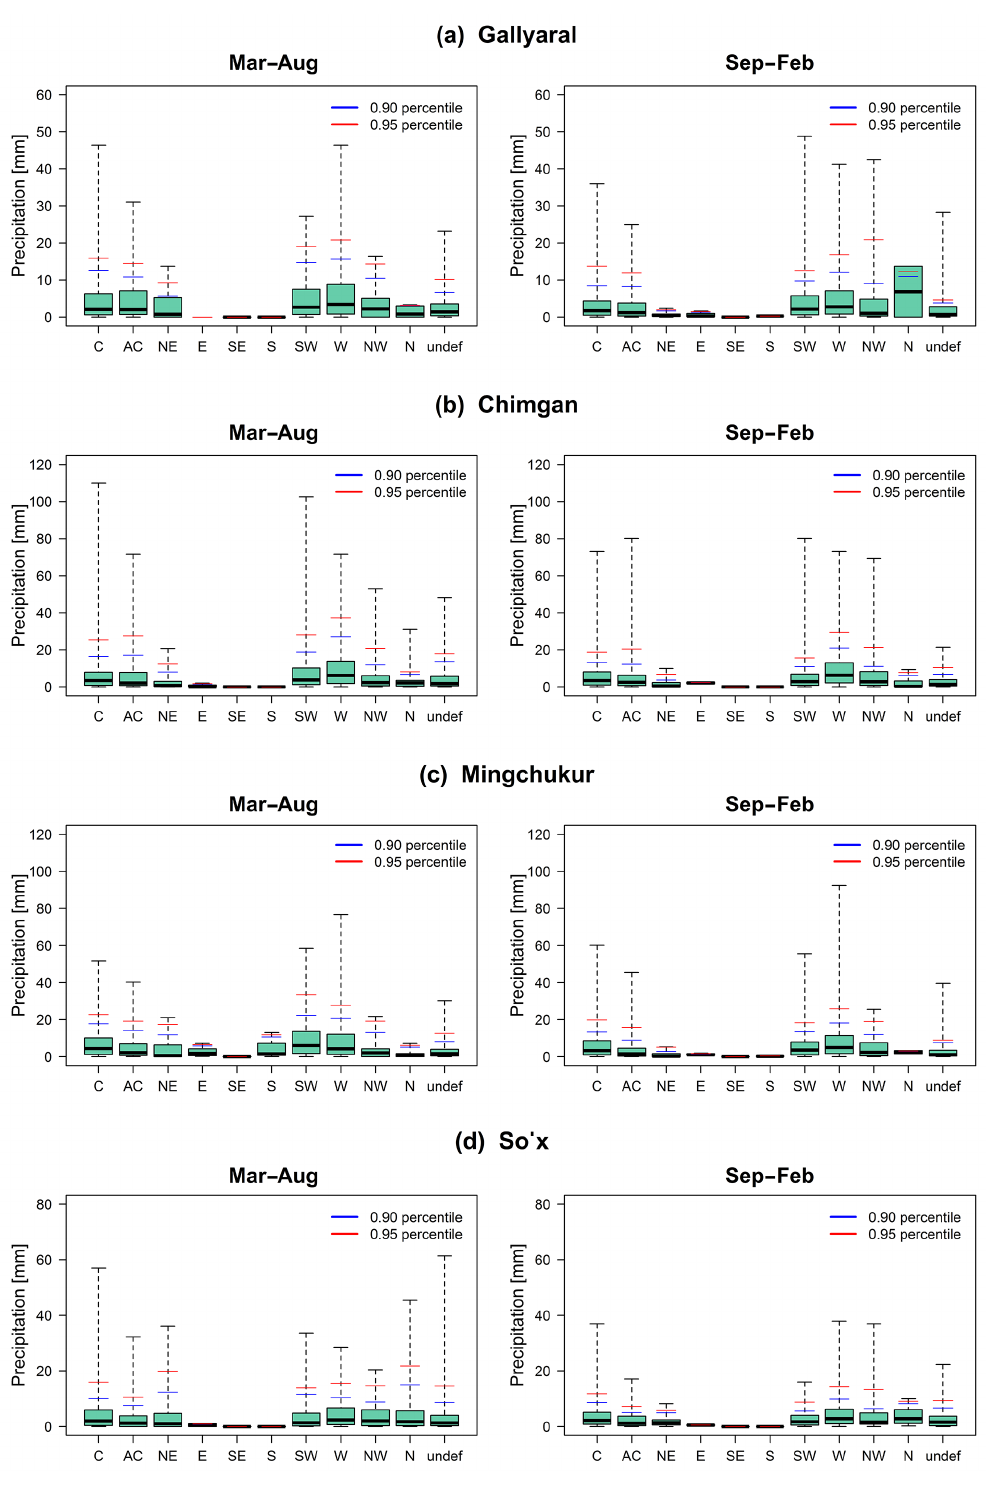
Figure 11. Box plots show daily precipitation (1984–2013) for each CWT class at four representative stations, namely Gallyaaral (Zerafshan basin), Chimgan (Chirchik–Akhangaran basin), Mingchukur (Kashkadar’ya and Surkhandar’ya basins) and So’x (Fergana Valley). The blue and red lines represent percentiles 0.90 and 0.95 of the precipitation for each class. The panels have different